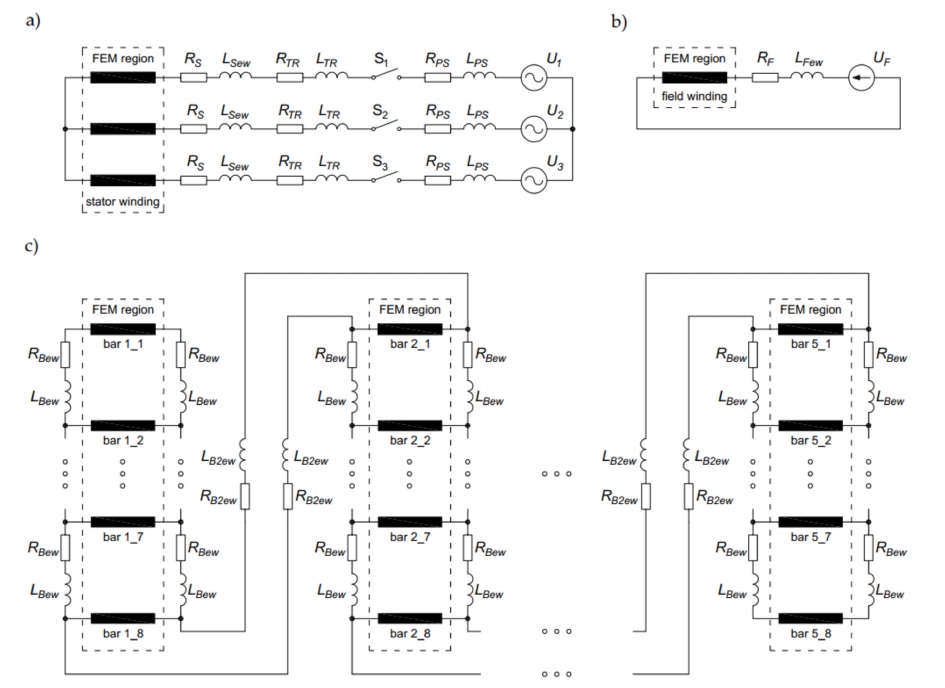
Figure 2. Schemes of stator winding ( a ), rotor winding ( b ), and distribution of damper bars ( c ) associated with the field model of the hydro generator.